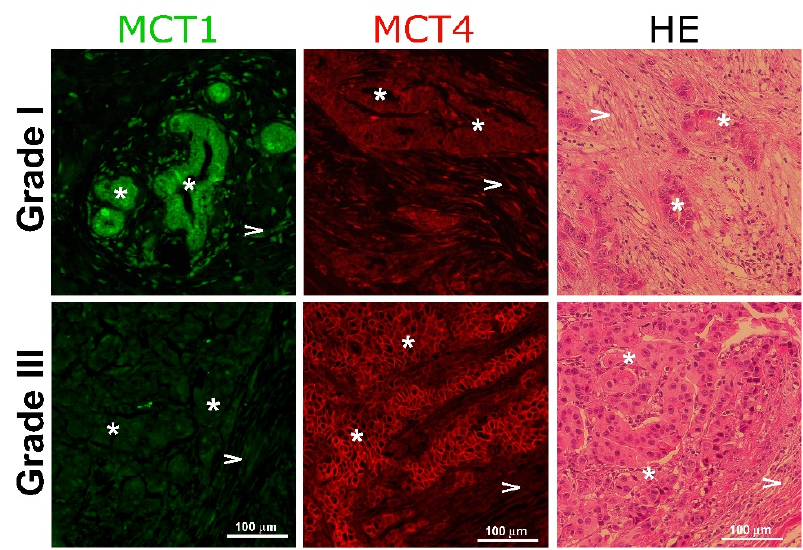
Figure 6. Monocarboxylate expression in human breast cancer samples. Representative immuno- histochemical staining of human breast tumor samples with different Elston grades stained for MCT1 (green) and MCT4 (red), taken with a magnification of 20×. The third column represents the control stain with hematoxylin-eosin. Asterisks (*) indicate epithelial cells and arrow heads (>) show stromal cells.